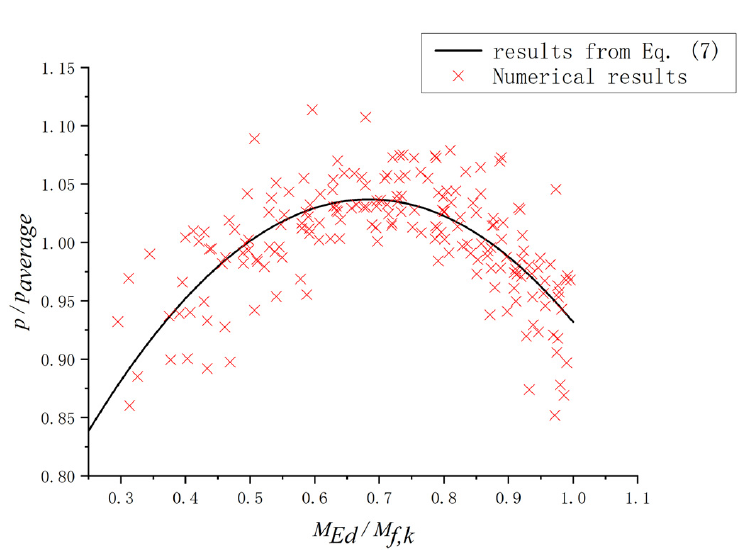
Figure 21. Comparison between numerical results and results from Equation (7) .